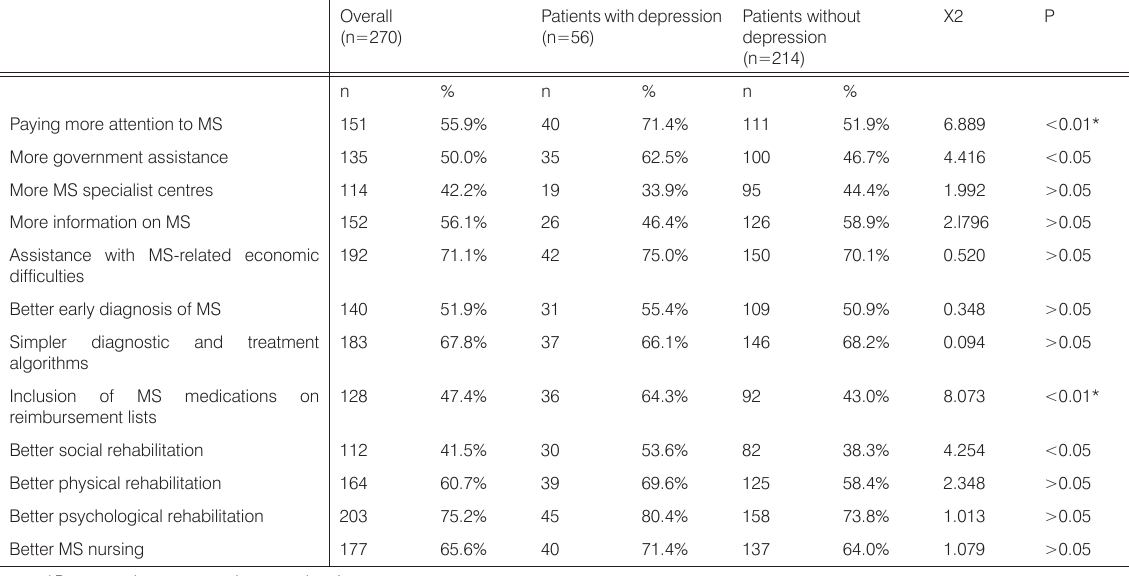
Table 4. Proportion of patients with and without depression identifying specific proposals as important for improving the management of